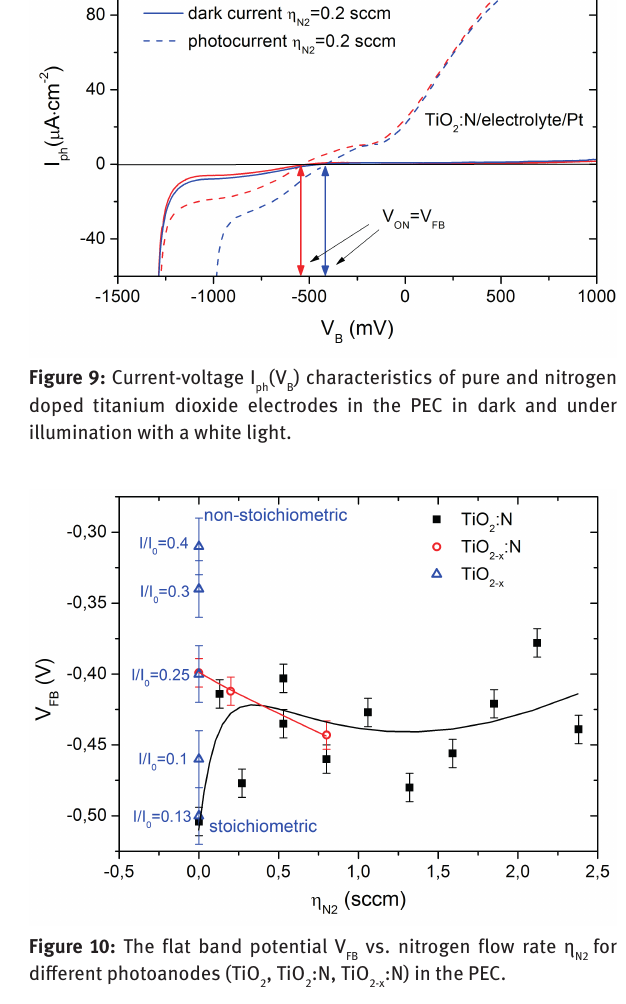
Figure 10: The flat band potential V different photoanodes (TiO